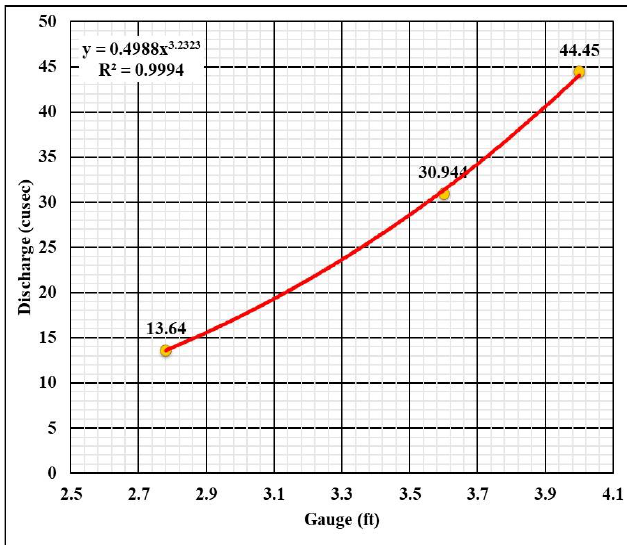
Figure 3: Represents a linear curve of measured discharge on different stage height